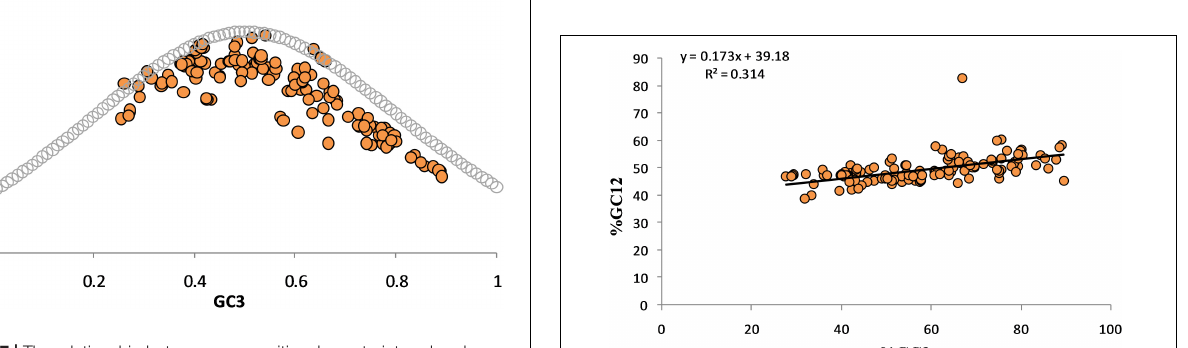
FIGURE 7 | The relationship between compositional constraint and codon usage bias. ENc-GC3 curve indicates the presence of selection and mutational forces on codon bias of genes. Data points far from the standard curve indicate action of forces other than compositional constraints acting on codon usage choices.